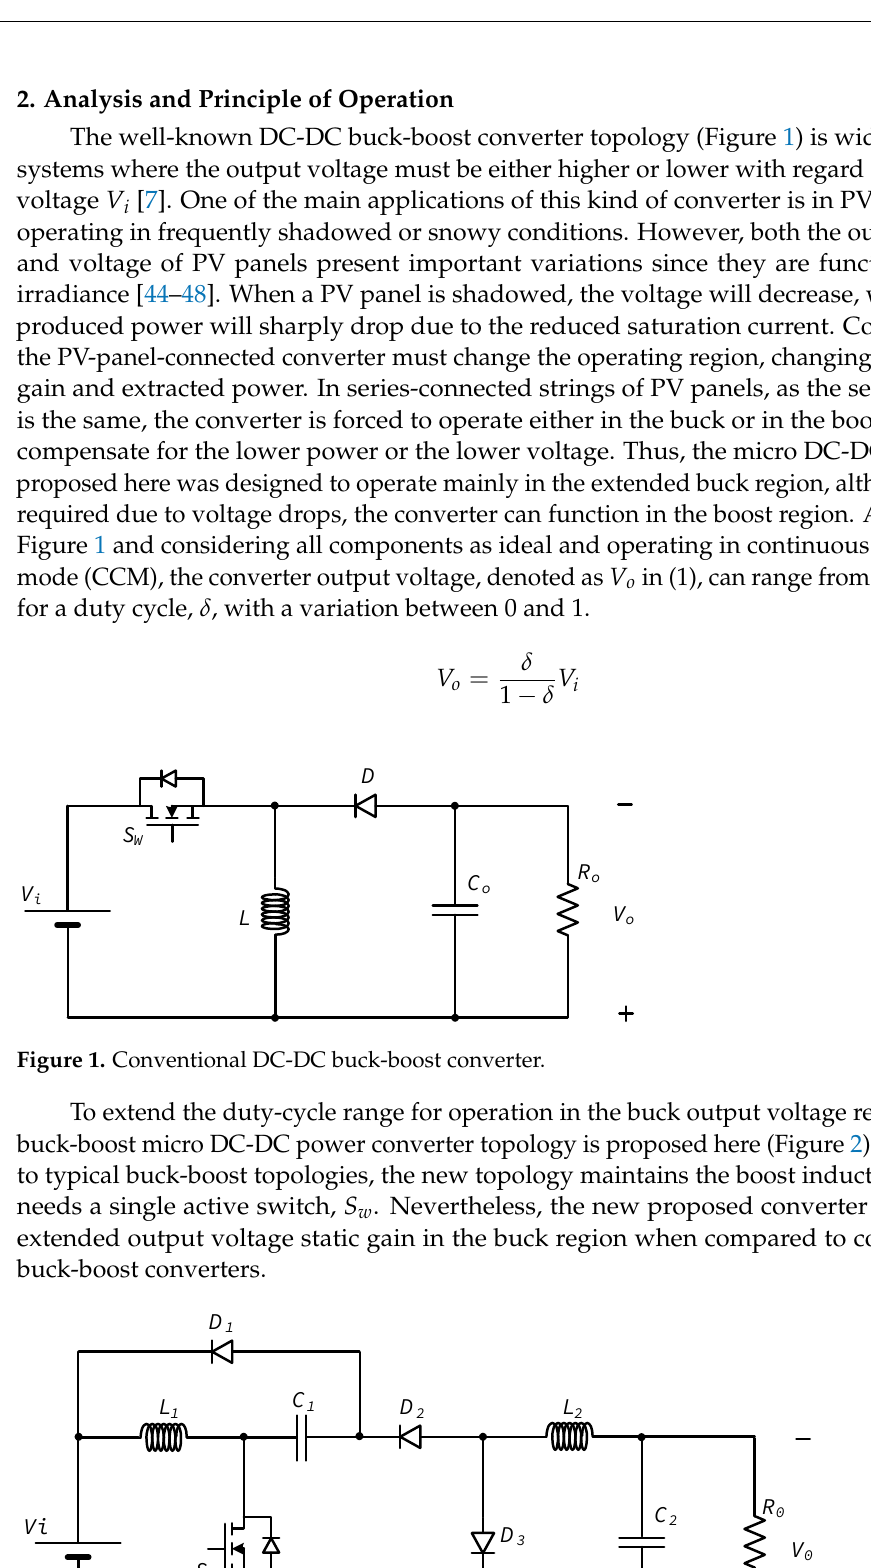
( b ) Figure 3. Converter operation modes. ( a ) Mode 1 — S w is ON. ( b ) Mode 2 — S w is OFF.